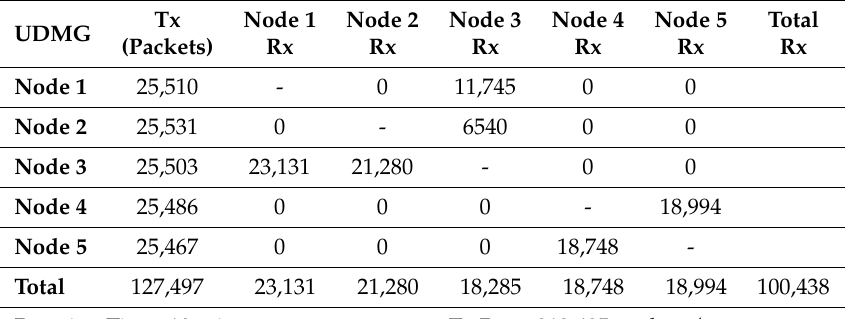
Table 7. Packet delivery: Cooja UDMG model.